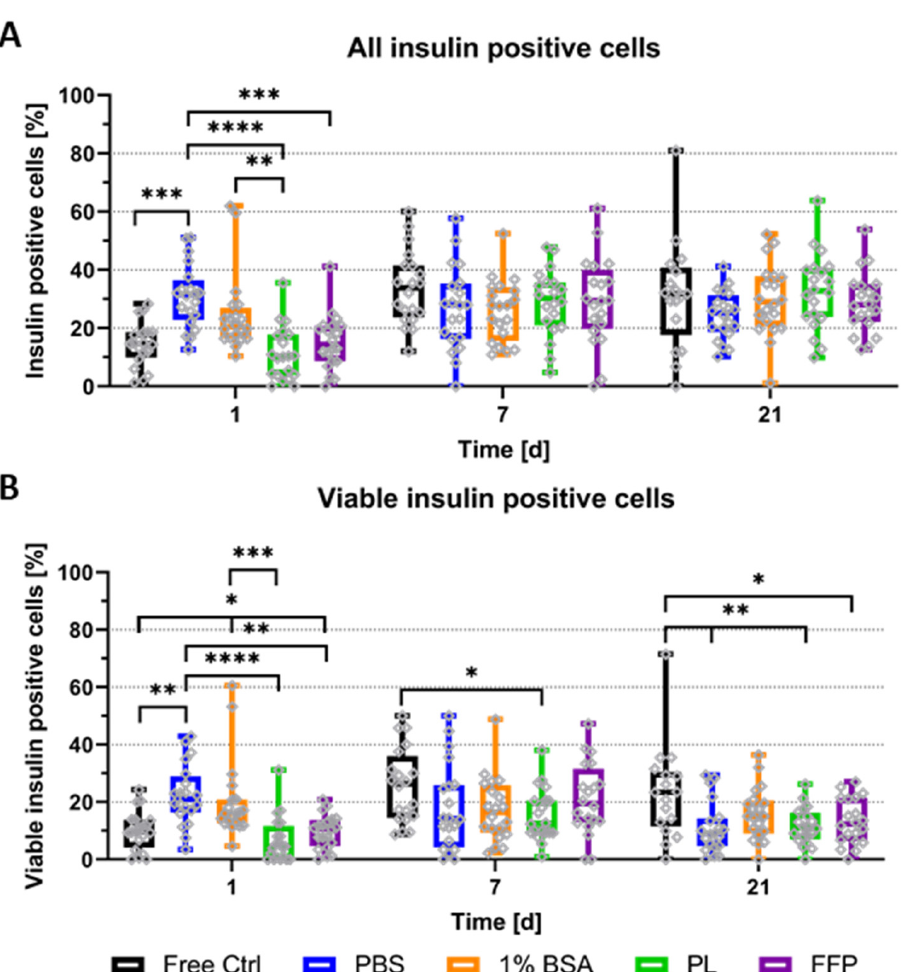
Figure 5. Quantitative analysis of insulin-producing cells in NICC. Analysed groups are free control NICC in suspension culture and NICC bioprinted in PBS-algMC, BSA-algMC, PL-algMC, and FFP- algMC. ( A ) Percent insulin-positive of all cells per islet cluster, including double-positive cells for insulin and TUNEL; ( B ) Percent viable insulin-positive of all cells per islet cluster, excluding double- positive cells for insulin and TUNEL. Mean ± SD, n = 1, 20 NICC. Grey dots in all graphs indicate individual islets, significances indicate * p < 0.05, ** p < 0.01, *** p < 0.001, **** p < 0.0001. Differences between the conditions are more clearly apparent when cells, those double- positive for TUNEL and insulin, are excluded, and only viable insulin-containing cells are considered (Figure 5B). Viable insulin-positive cells increased over time in free control NICC. Compared to bioprinted NICC, their number was comparable to PL- and FFP-algMC, smaller by trend than BSA-algMC, and significantly smaller than PBS-algMC on day 1. From day 7 onwards on the other hand, free control NICC contained more viable insulin- positive cells than those in bioprinted scaffolds, partially by trend, partially significantly more. This is only the case when apoptotic insulin-positive cells are excluded in accordance with an overall higher amount of apoptotic nuclei (Figure 3B) between free control